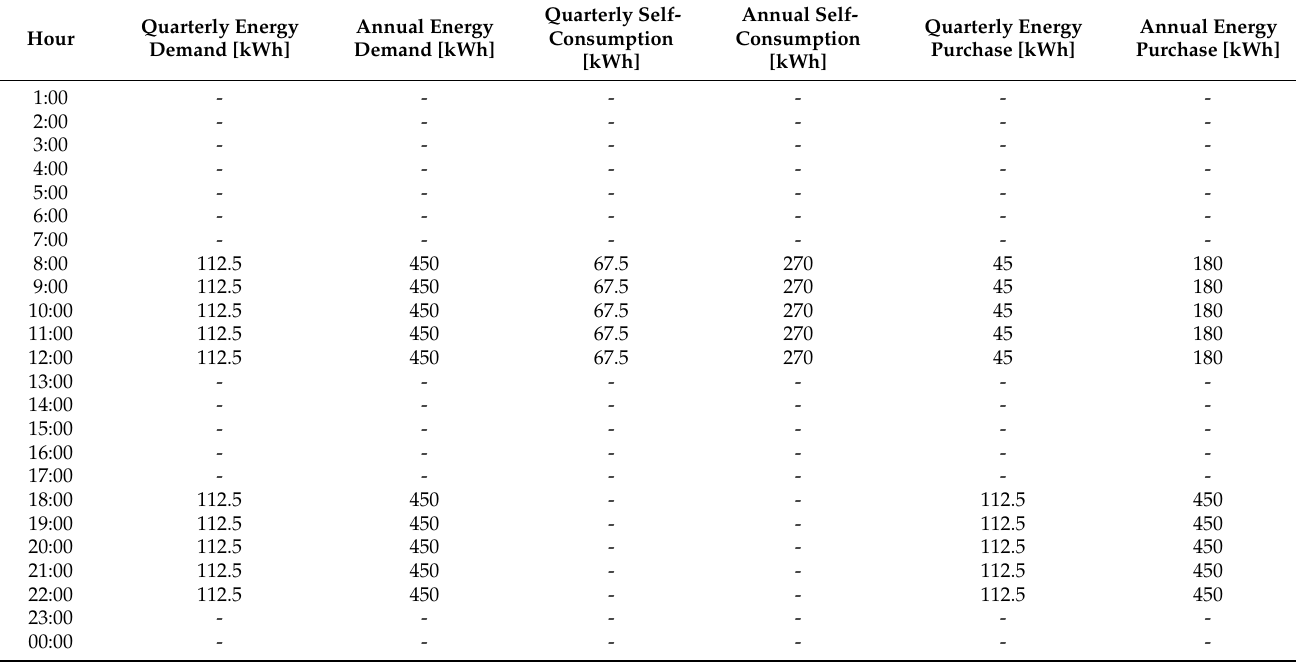
Table 7. An hourly profile of the household, which takes into account energy demand, self- consumption, and energy to be purchased on a quarterly and annual basis during the autumn and winter